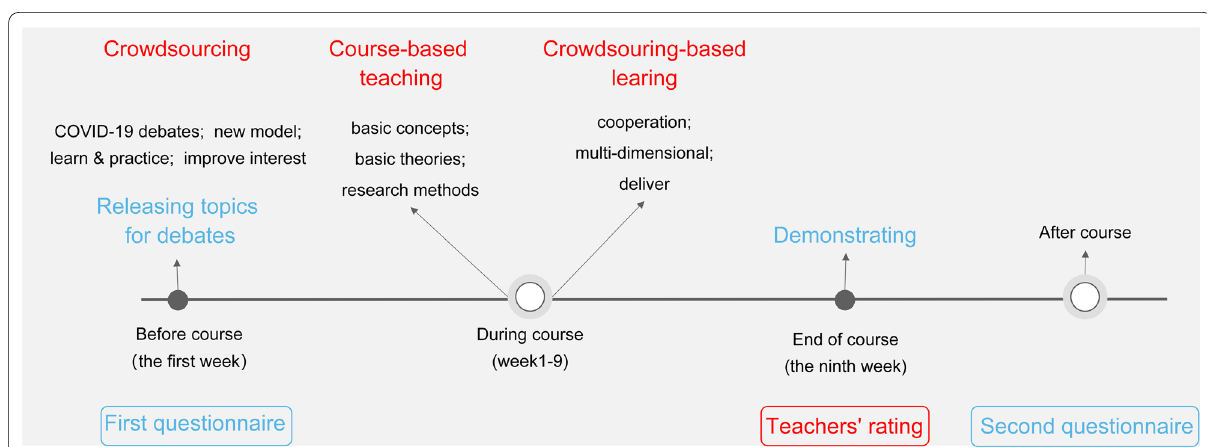
Fig. 2 Overall design of the crowdsourcing-based teaching